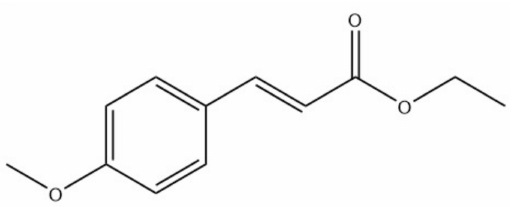
Figure 5. Chemical structure of ethyl trans- p